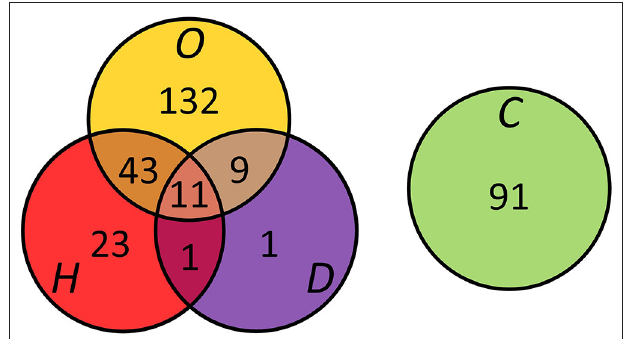
FIGURE 1 | Presence and overlap of overweight (O), hypertension (H), and type 2 diabetes (D) in the study population (n = 311). Controls (C) were free of risk